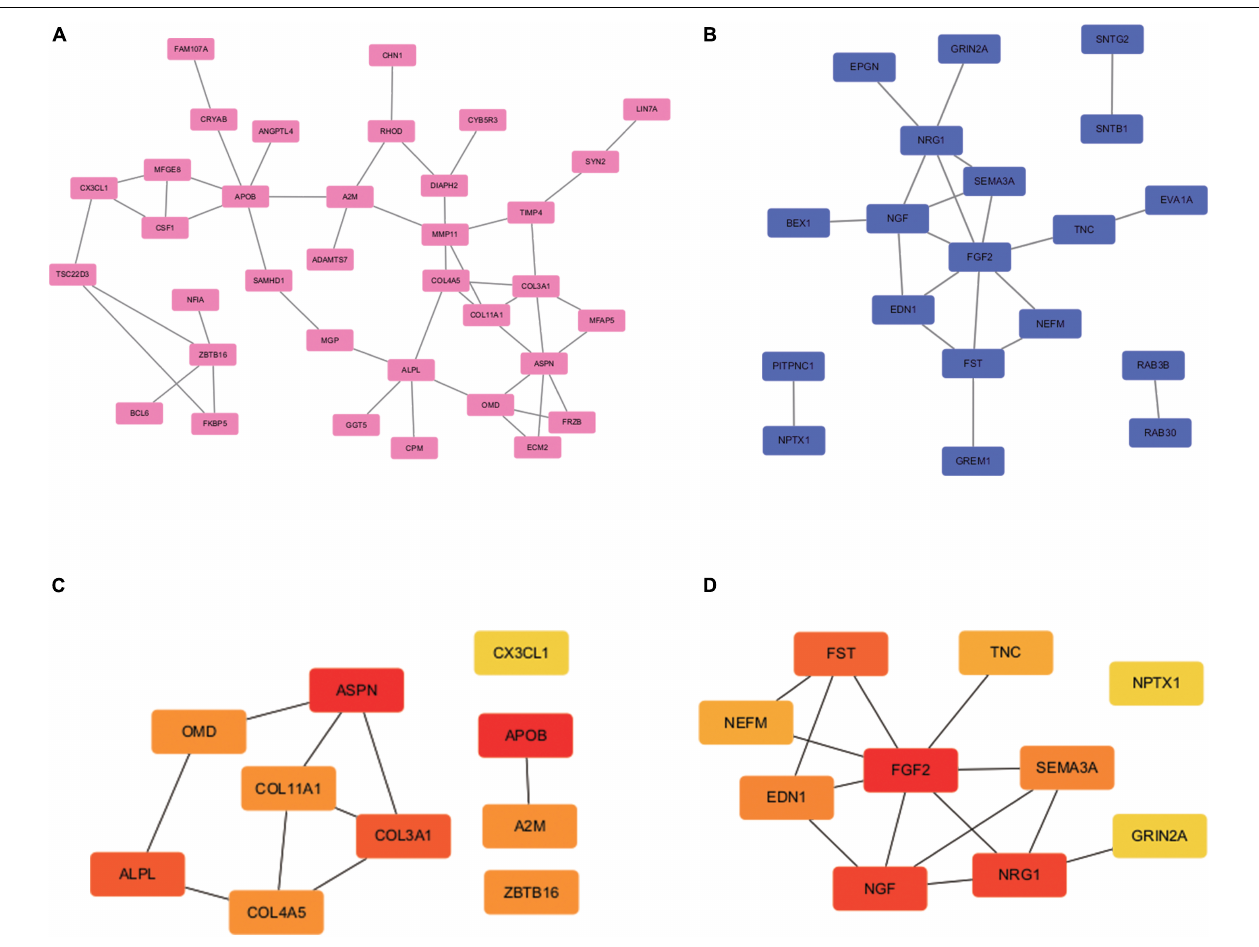
FIGURE 3 | PPI network construction and hub genes screening. PPI network construction and module analysis (A) and (B) shows the PPI network of DEGs. The 62 up-regulated genes (35 nodes, 46 edges) are marked in red, while the 52 down-regulated genes (19 nodes, 21 edges) are marked in blue. The 10 up-regulated hub genes (C) and 10 down-regulated hub genes (D) were identified in the densest connected regions with the Degree algorithm, using cytoHubba. The score is indicated in red color. Darker color indicates a higher score.